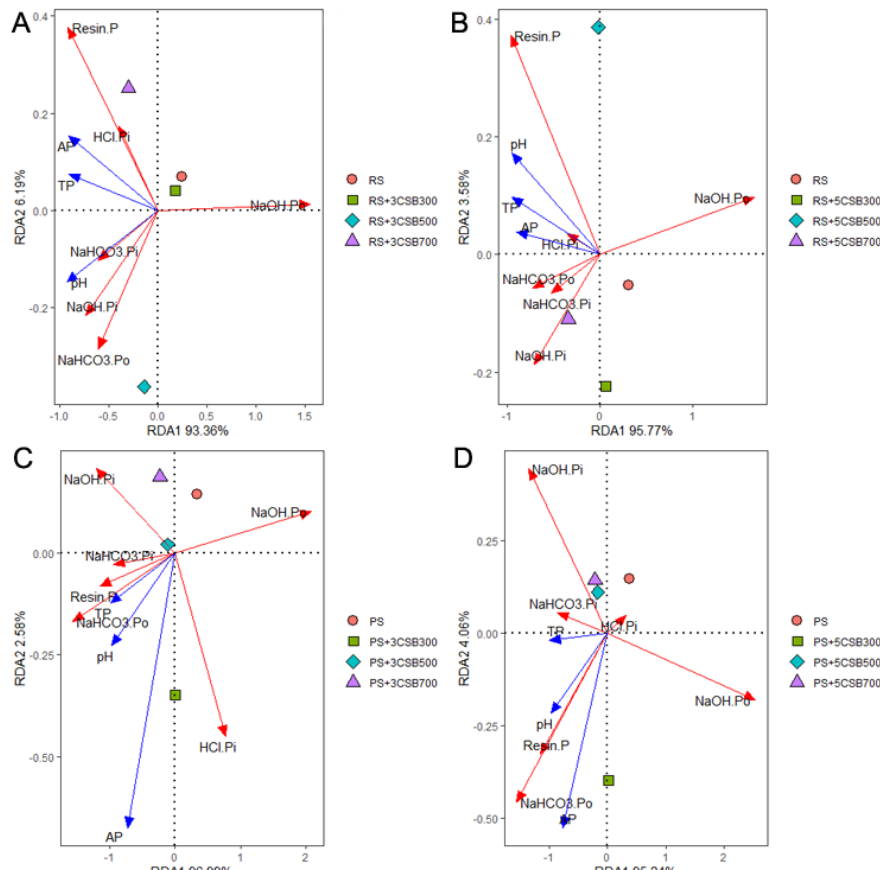
Figure 1. Redundancy analyses (RDA) of the correlations between soil chemical properties and P fractionation in all treatments. ( A ): RDA of red soil with 3% application rate of C. oleifera shell biochar (CSB); ( B ): RDA of red soil with 5% application rate of CSB; ( C ): RDA of purple soil with 3% application rate of CSB; ( D ): RDA of purple soil with 5% application rate of CSB; The blue arrows indicate the soil chemical properties had a significant effect on soil inorganic P fractions ( p < 0.05).